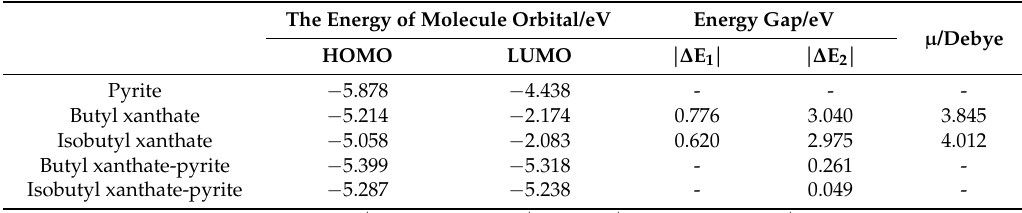
Table 5. Frontier orbital energy of xanthates and